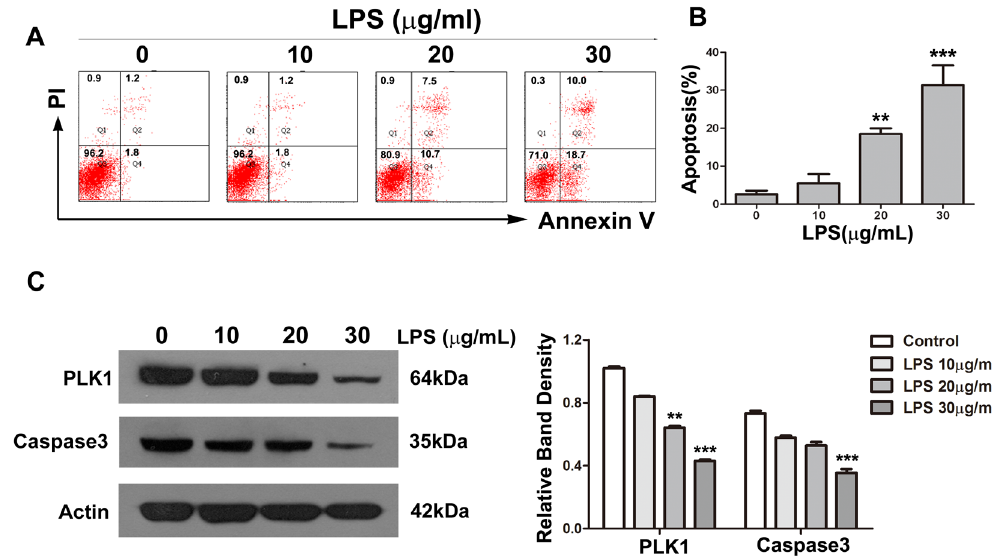
Figure 5. LPS induces apoptosis in HT29 cells. ( A ) HT29 cells were exposed to various concentrations of LPS for 24 h. Apoptosis was analysed by Annexin V-FITC/PI double-labelling assay. ( B ) The degree of apoptotic cell death was quantified. Data represent the mean ± SD ( ** P < 0.01, *** P < 0.001 compared with control group.). ( C ) The levels of PLK1 and caspase-3 in HT29 cells after treatment with LPS at various concentrations for 24 h. The graph represents the relative band densities. Values are mean ± SEM (n = 3). ** P < 0.01, *** P < 0.001 versus control